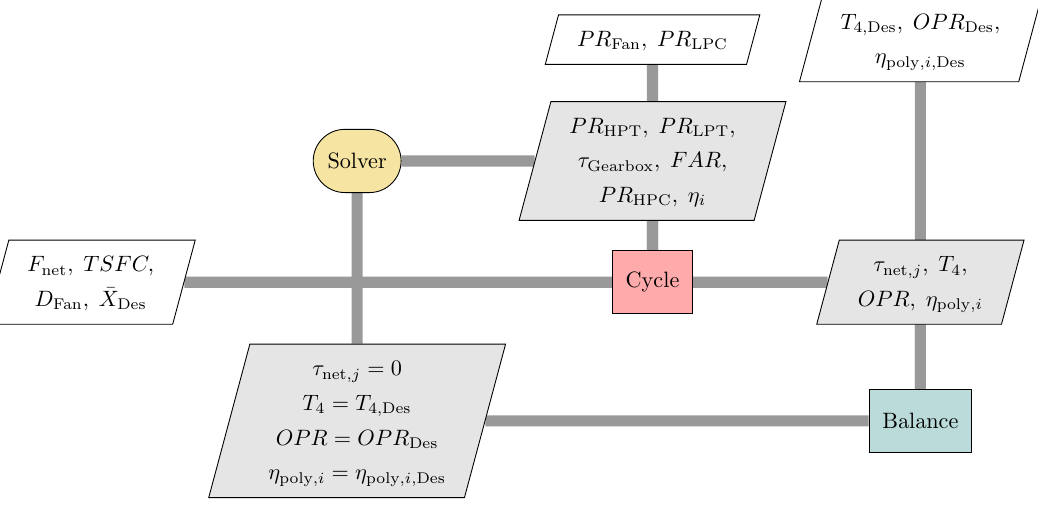
Figure 5. Reference engine model on-design analysis